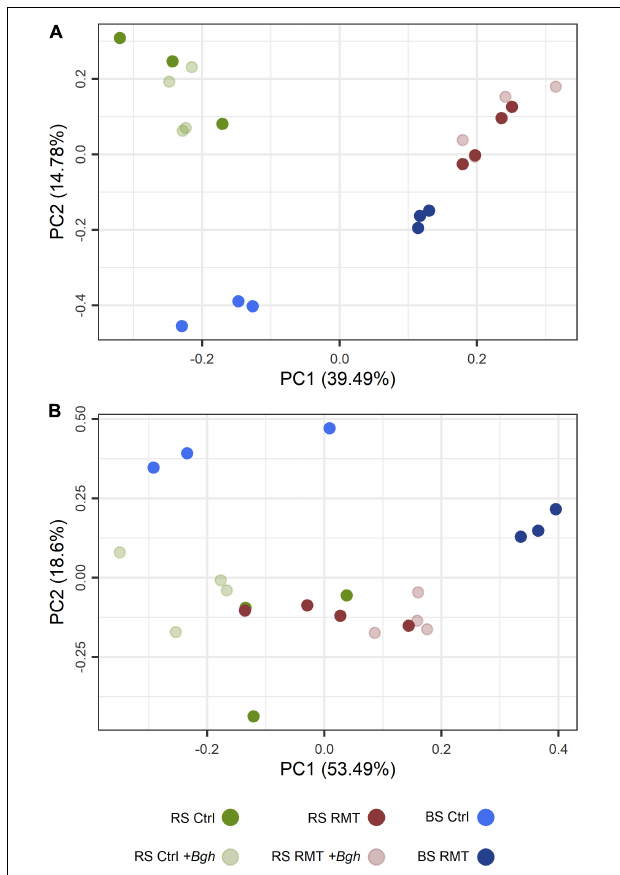
FIGURE 5 | Community composition and predicted functional profile of barley rhizosphere and bulk soil microbial communities. (A) Microbial community composition of barley rhizosphere (RS) and bulk soil (BS) was visualized by constrained principal component analysis (PCA) based on the relative abundances of rhizosphere microbiome transplant (RMT) and control (Ctrl) amplicon sequence variants (ASV), either infected with Bgh or not. (B) Predicted KEGG Orthologs (KO) for each microbial community of RS or BS, treated with either RMT or as Ctrl with and without Bgh infected, visualized by PCA based on the relative abundance of each predicted KO.